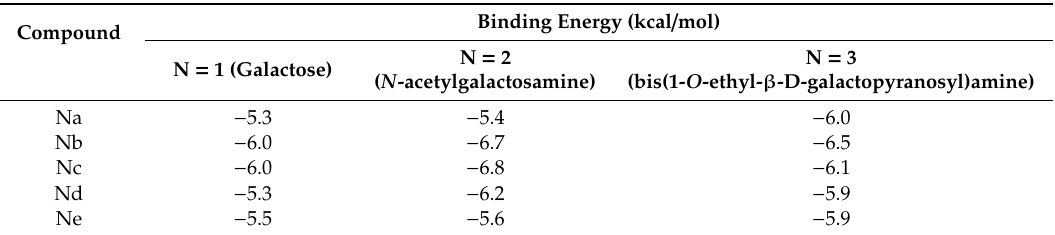
Table 1. Binding energies obtained from docking